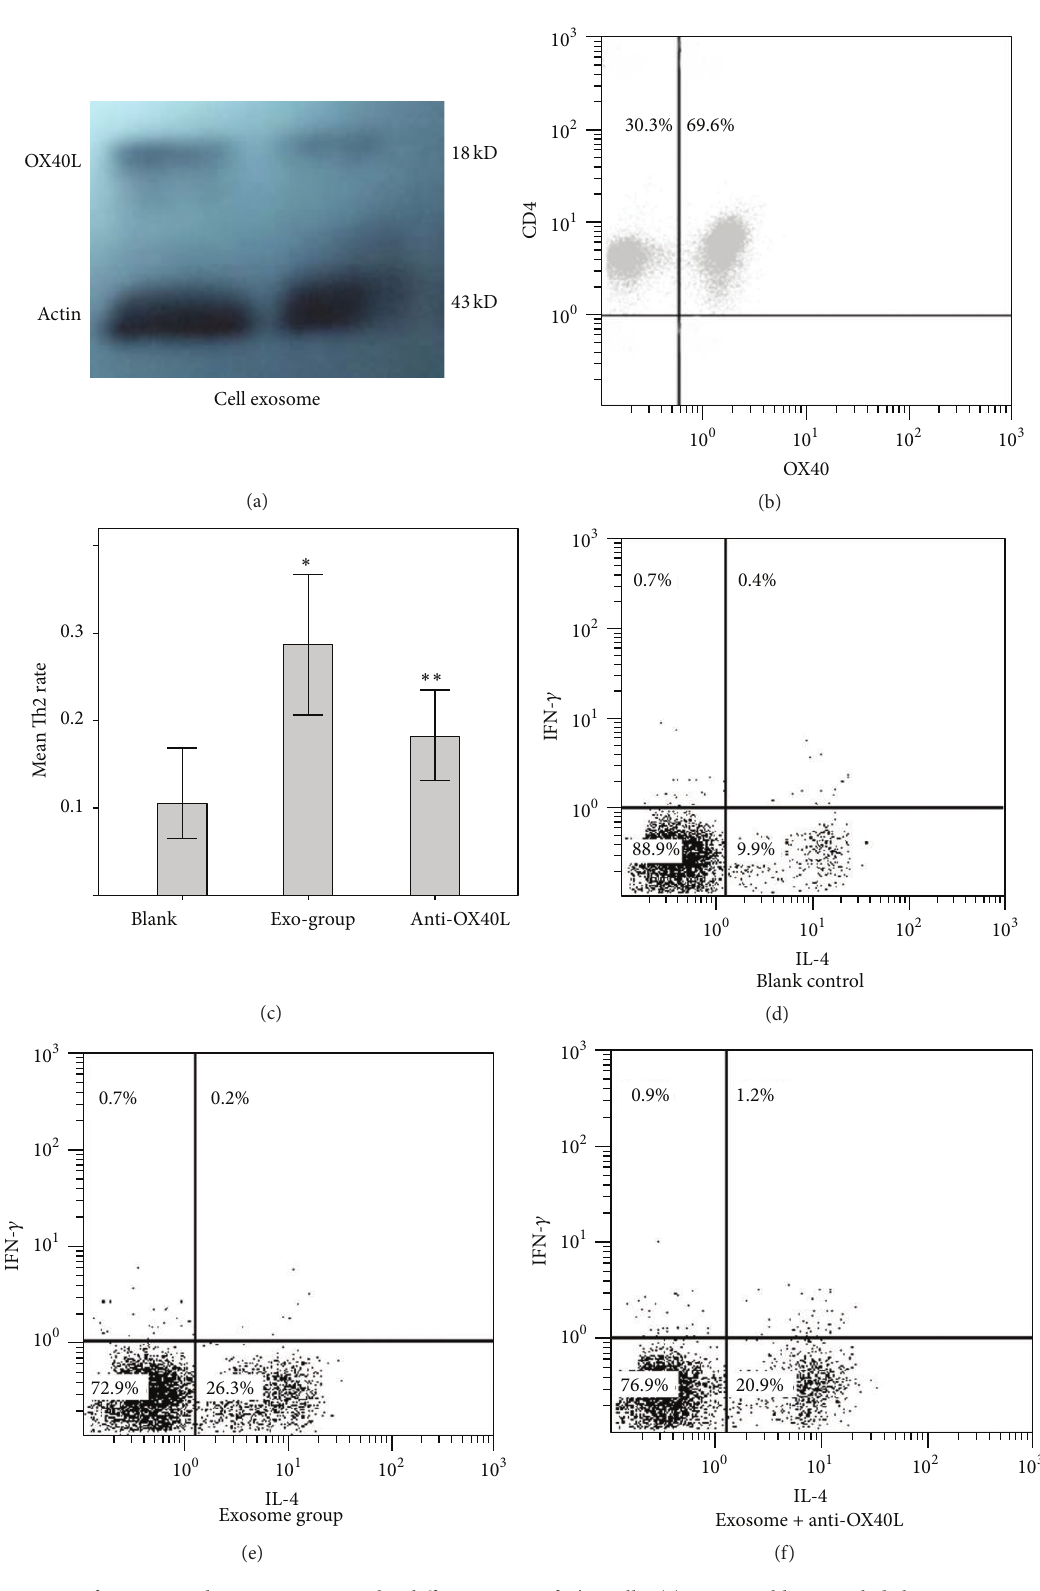
Figure 5: Ligation of OX40L and OX40 promotes the differentiation of Th2 cells. (a) Western blot revealed the expression of OX40L in BMMCs and their exosomes, but a lower expression on exosomes; (b) flow cytometry showed that naive CD4 + T cells expressed OX40; (c) Th2 expression in all the T cells was expressed as mean ± SD. ∗ , compared with blank control, 𝑝 < 0.05 . ∗∗ , compared with exosome group, 𝑝 < 0.05 . The results represented three independent experiments. (d–f) Addition of anti-OX40L Ab significantly but partially inhibited the differentiation of Th2 cells positive for